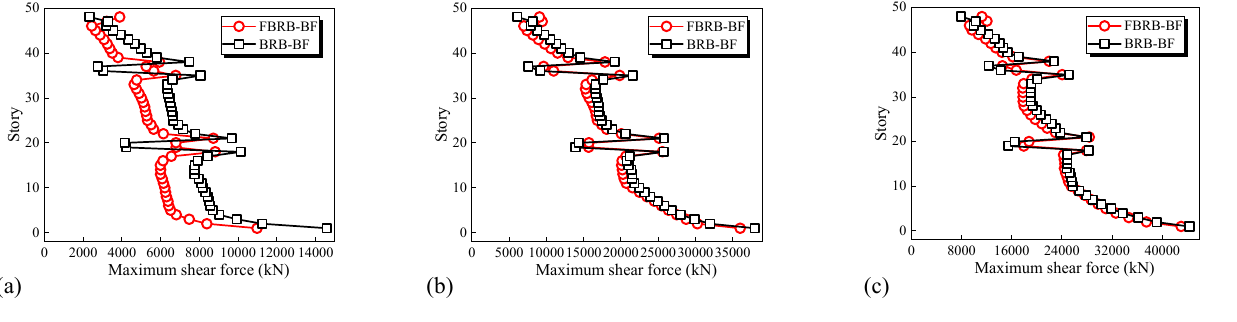
Figure 20. Distributions of story ‐ shear force: ( a ) PGA = 70 cm/s 2 ; ( b ) PGA = 400 cm/s 2 ; and ( c ) PGA = 620 cm/s 2 .